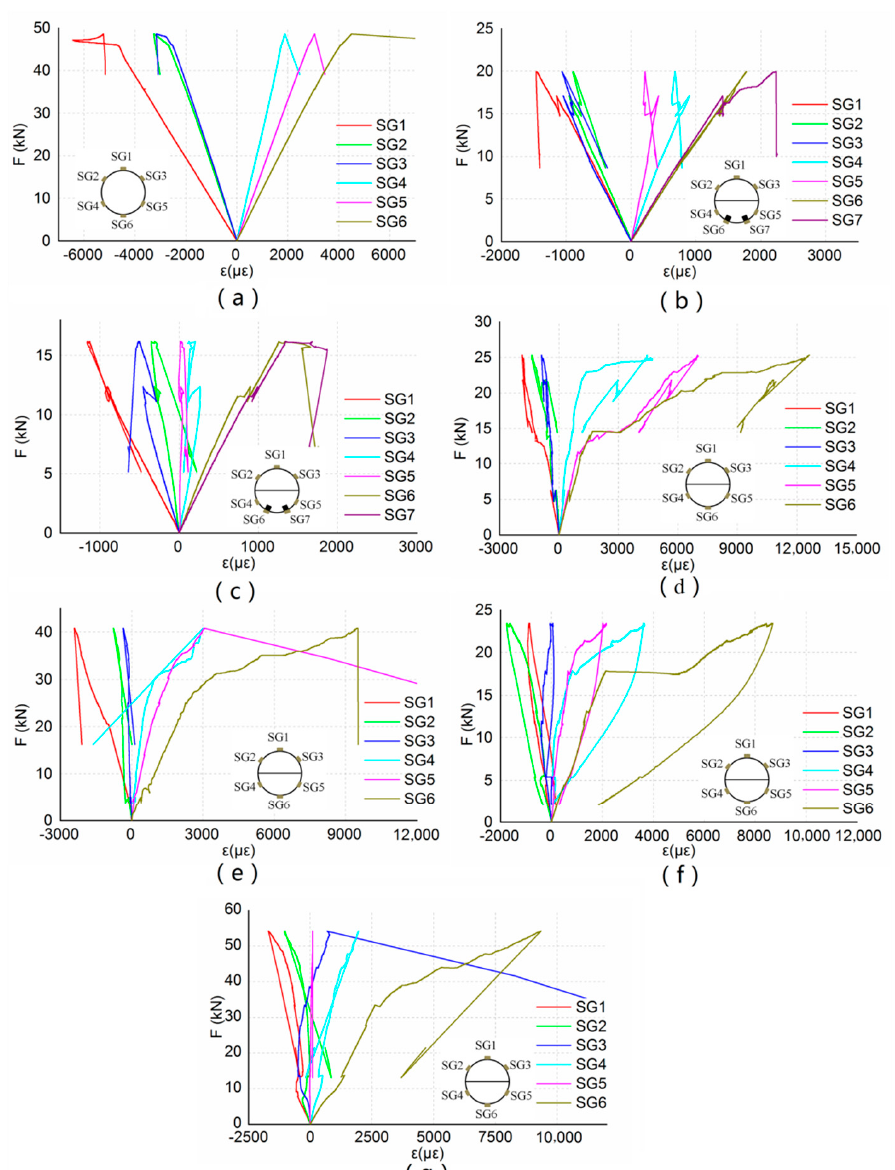
Figure 9. Load-strain diagram for bending beams. ( a ) Beam B0; ( b ) beam B1; ( c ) beam B2; ( d ) beam B3; ( e ) beam B4; ( f ) beam B5; ( g ) beam B6.